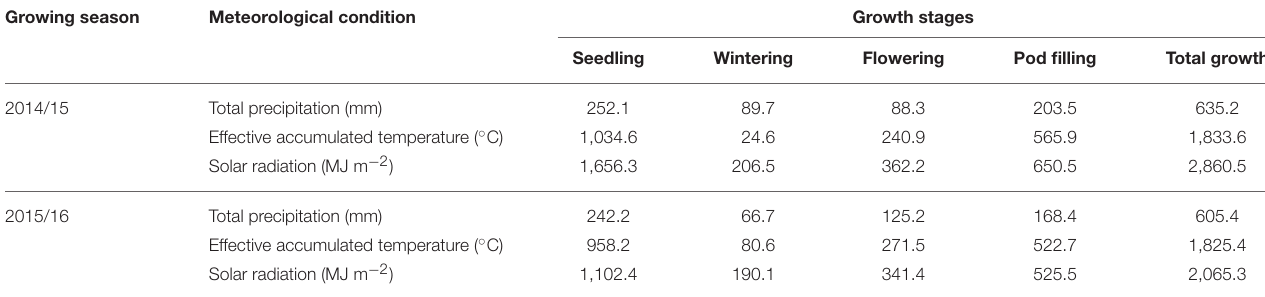
TABLE 2 | Meteorological conditions during the study conducted for two consecutive winter rapeseed-growing seasons. Growing